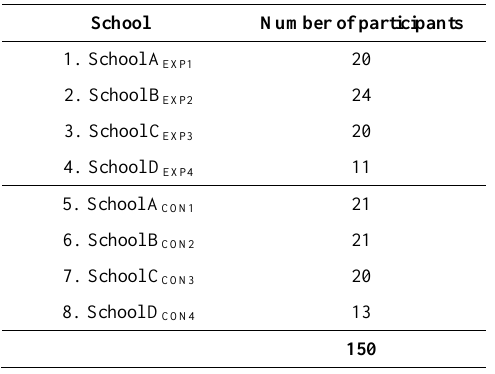
Table 2. Number of students involved in the research